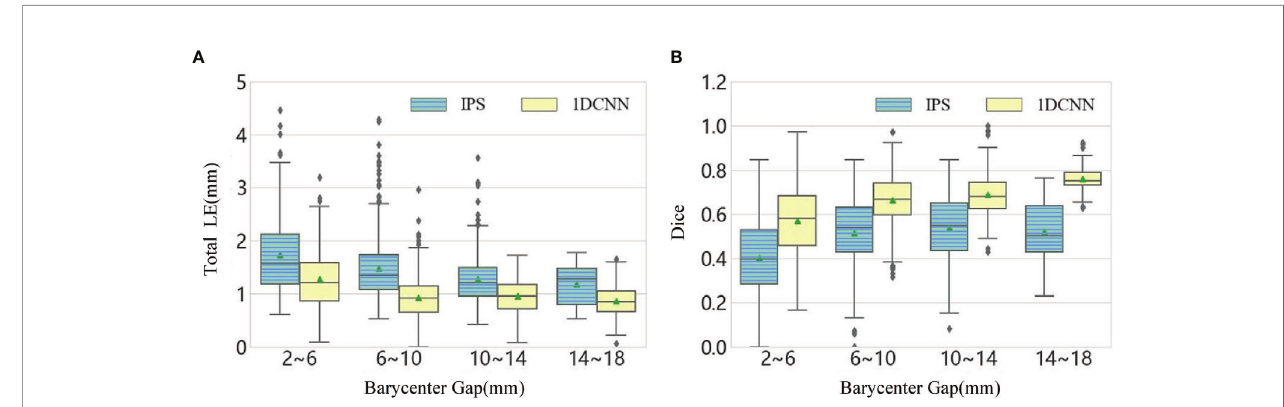
FIGURE 4 | (A) The boxplot chart of the total LE for the dual-source samples, where the samples are divided into four classes according to the barycenter gap. (B) The corresponding boxplot chart of the